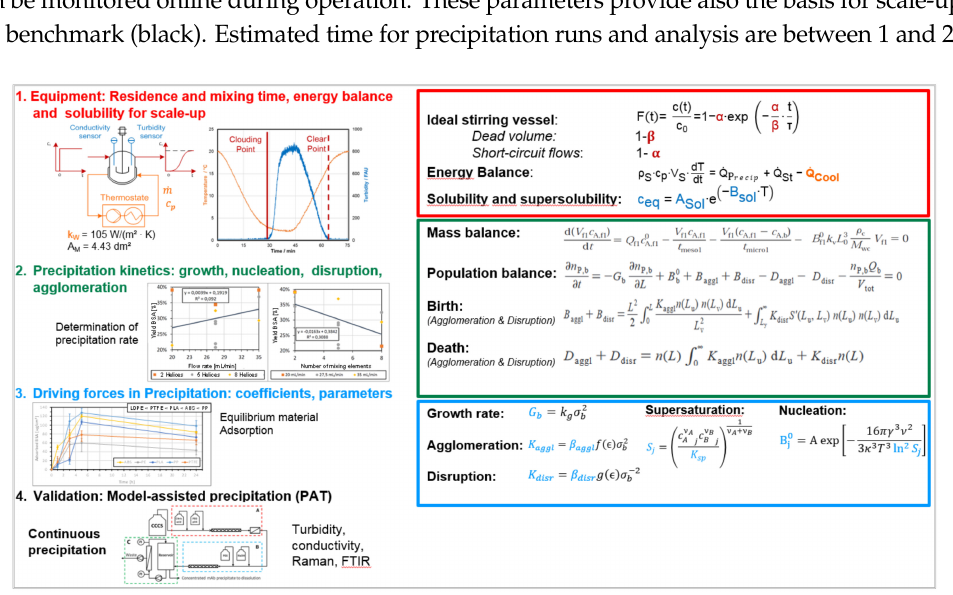
Figure 9. Precipitation process modeling workflow, recipe, SOP.